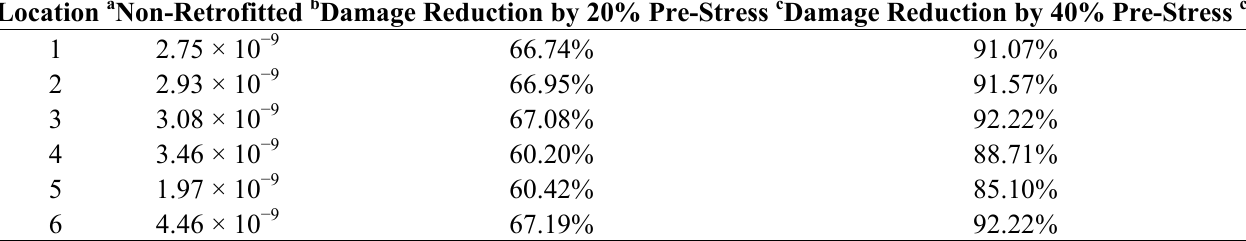
Table 3. Fatigue damage reduction at different CFRP pre-stress levels due to S3 train passage for ( a ) cross-beam bottom flange locations and ( b ) longitudinal-to-cross-beam connection locations.